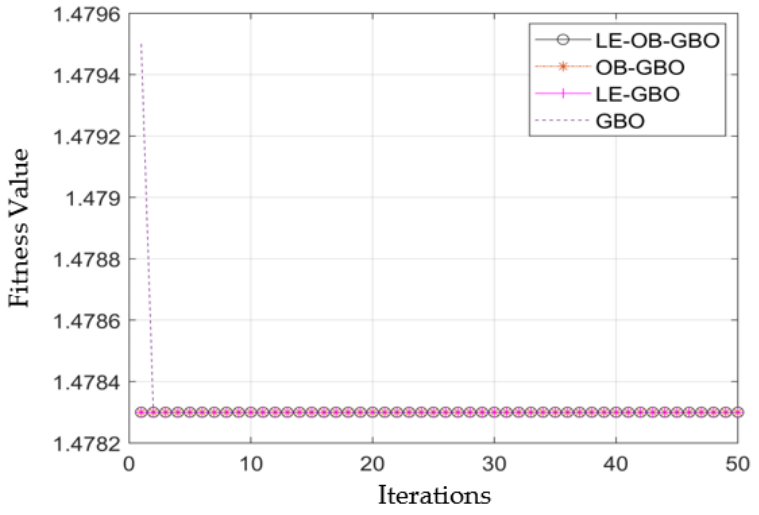
Figure 6. Convergence curve for the charging station placement problem — case 2.